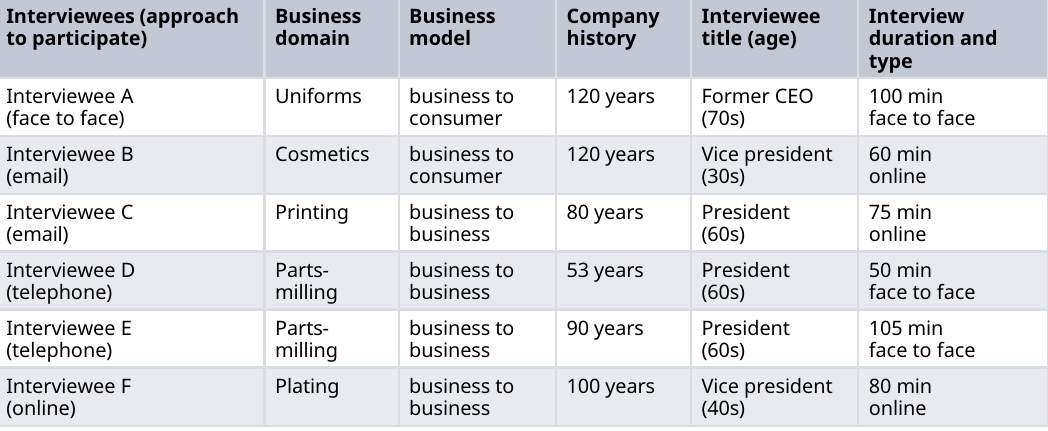
Table 2. The interviewees included in the study. Interviewees (approach to